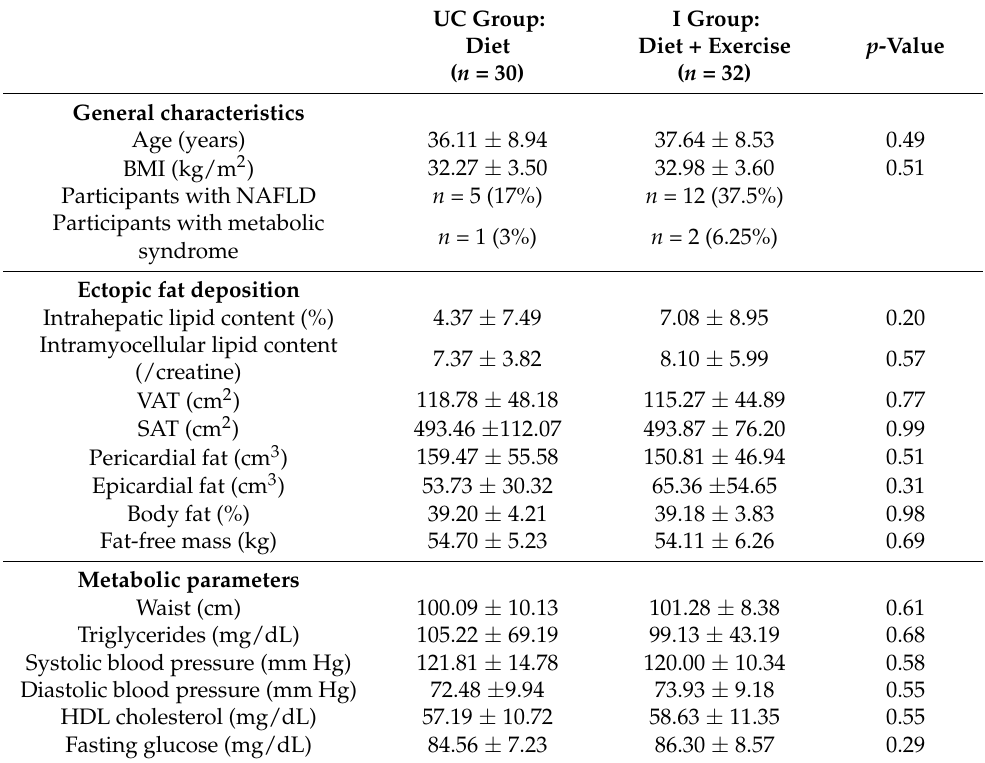
Table 1. Descriptive statistics of study participants (mean ±